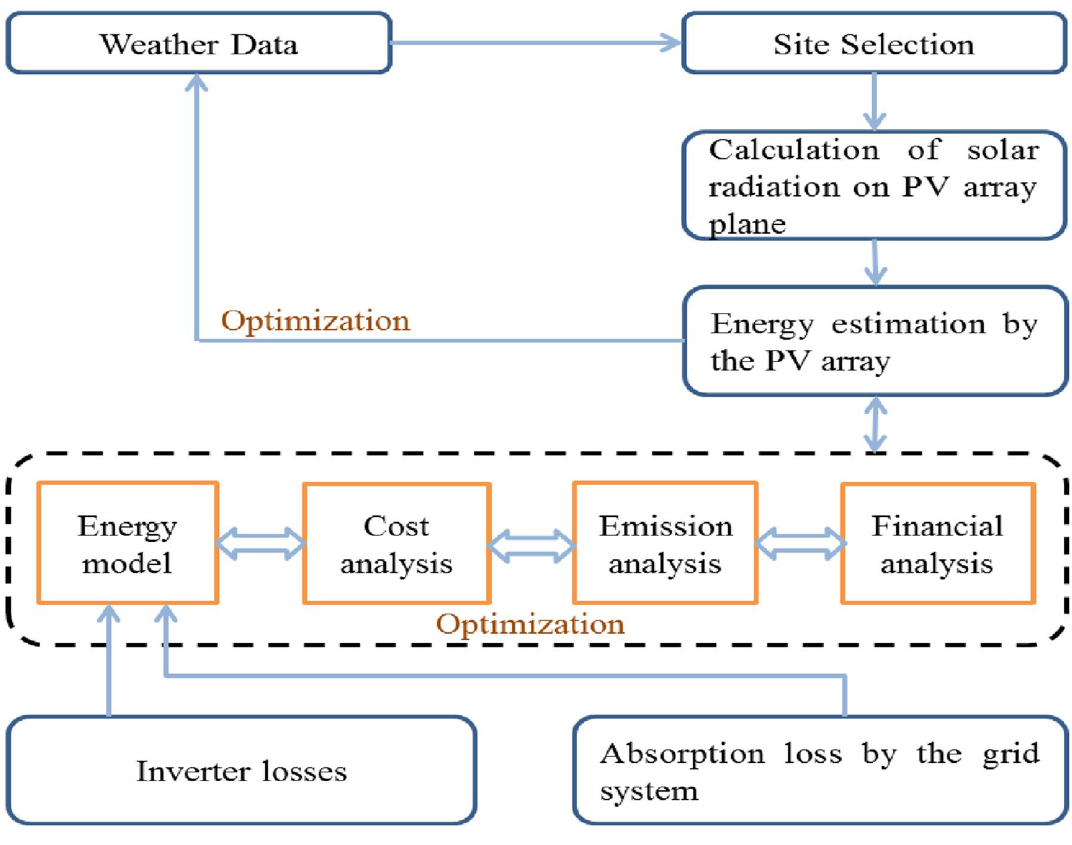
Figure 2. Photovoltaic energy model